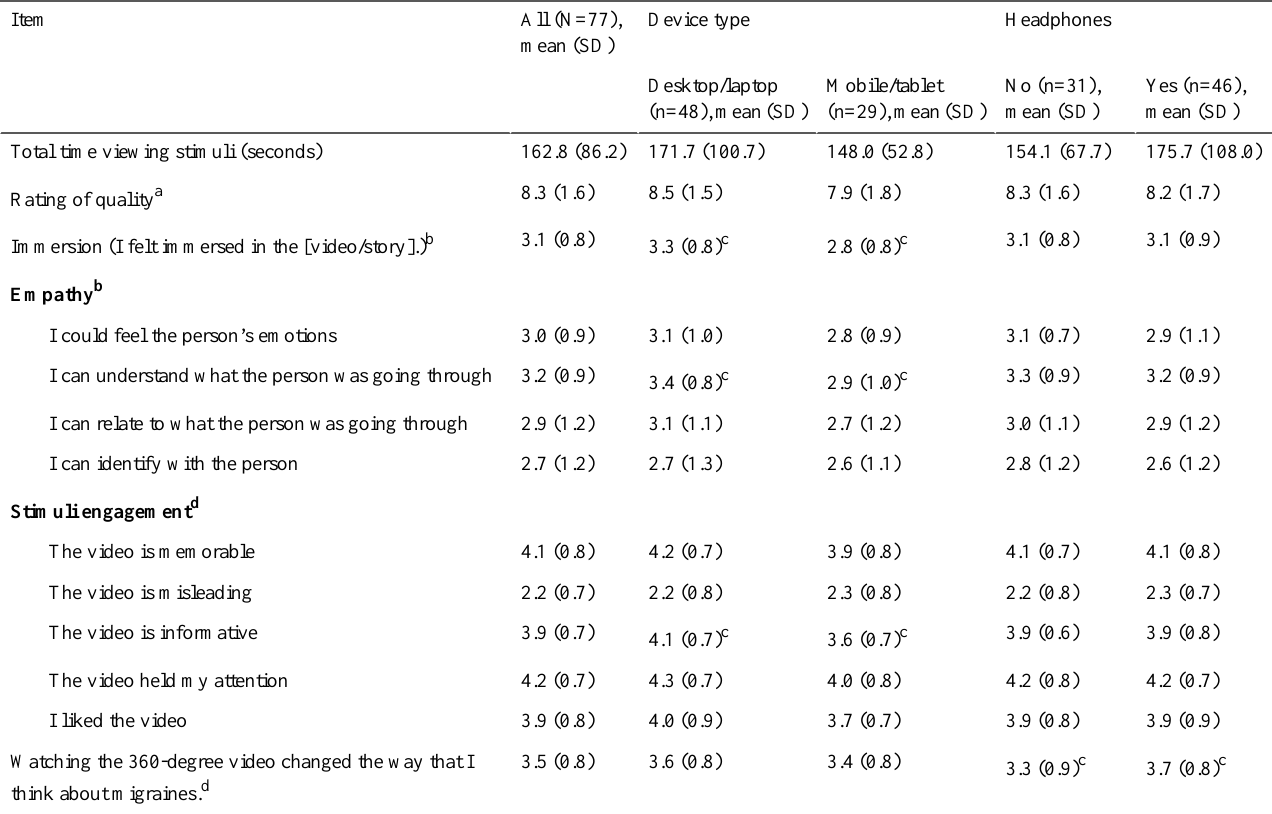
Table 1. Empathy and engagement for 360-degree video by device type and headphone use.